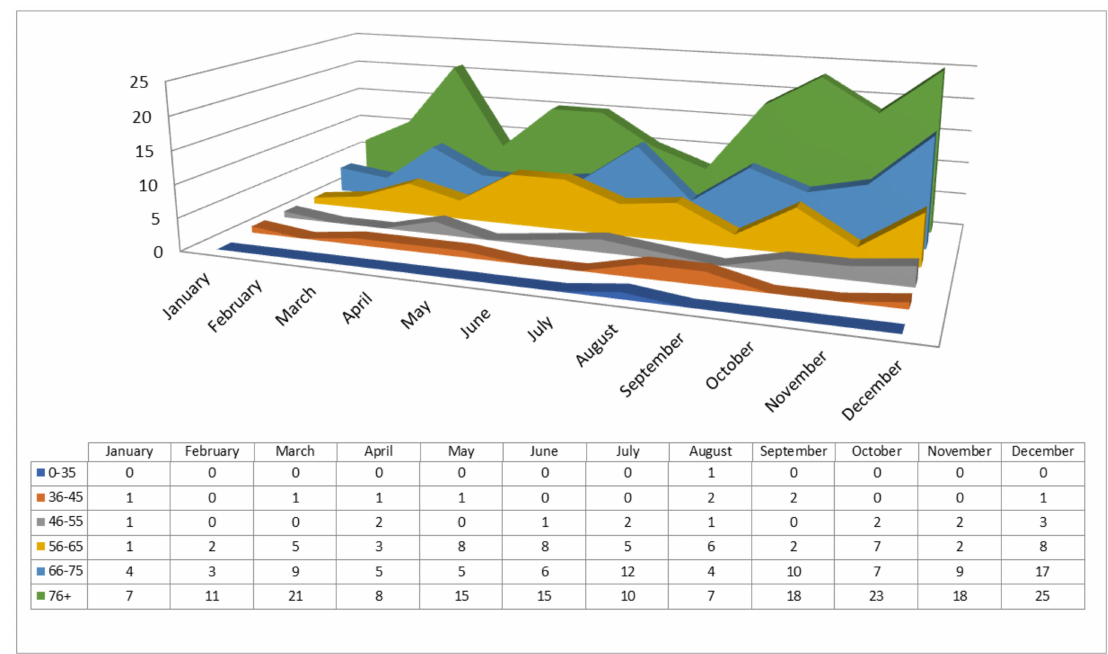
Figure 4. Positive results of the hs-cTn I test distributed by months and the six age